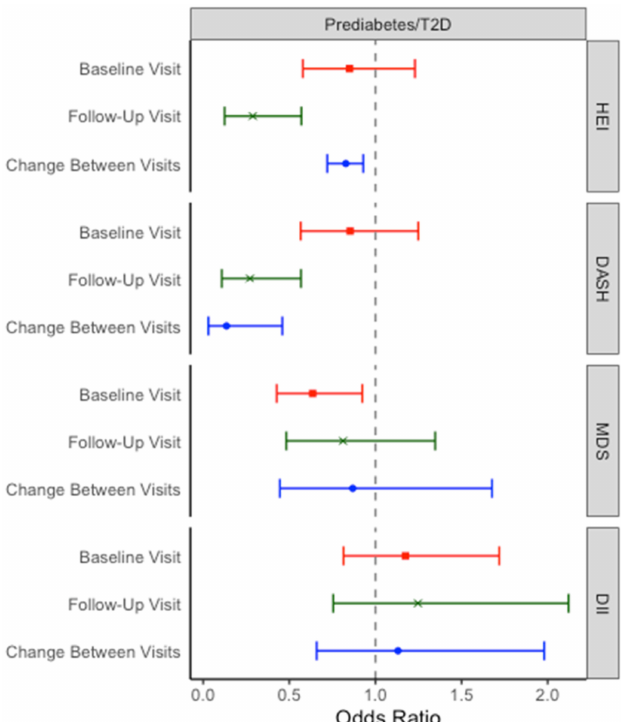
Figure 1. Coefficient plots for the effects of diet quality on prediabetes. “Baseline” and “follow-up” values are the result of cross-sectional analyses of diet quality score and risk of prediabetes/T2D at the same visit. The value for “change between visits” represents the risk of prediabetes/T2D at the follow-up visit associated with change in diet score between the baseline and the follow-up